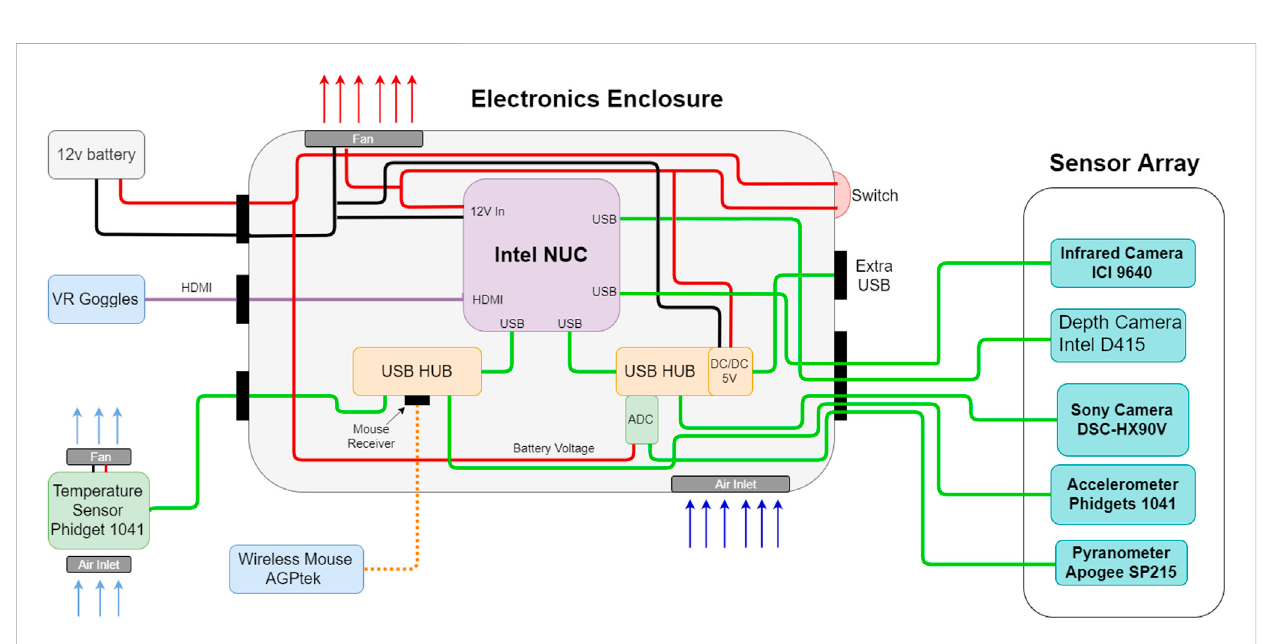
FIGURE 2 Schematic of the PlotCam instrument